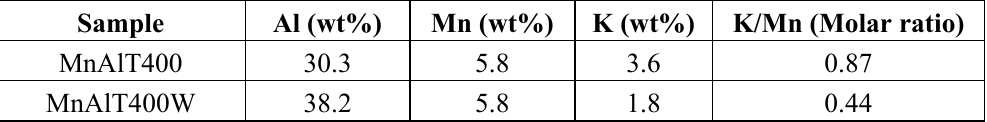
Table 1. Atomic Absorption Spectrometer (AAS) elemental analysis.